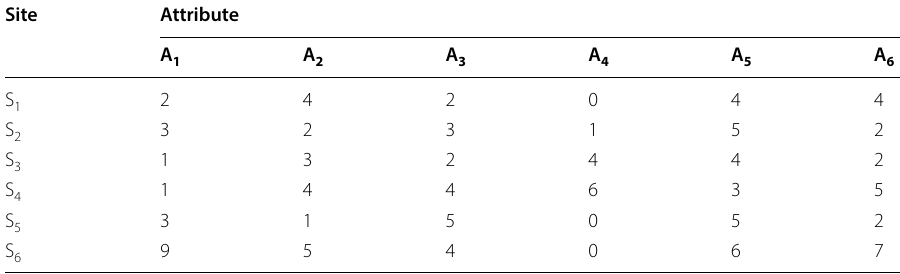
Table 13 Site Access Attribute Matrix